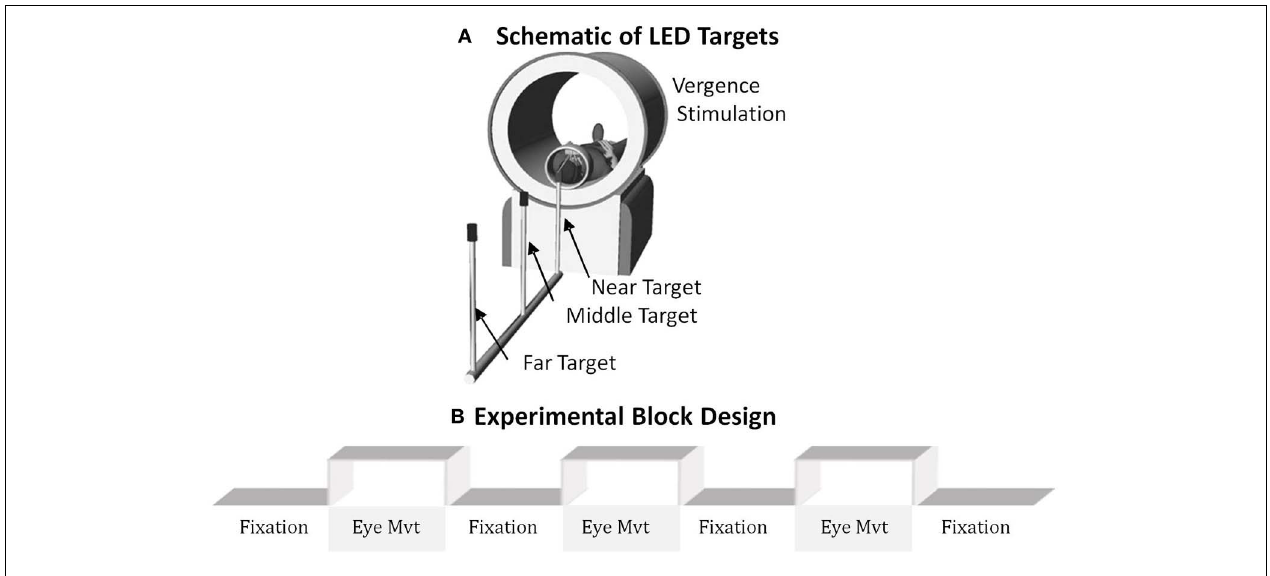
FIGURE 1 | (A) Schematic of the LED targets showing visual stimuli. (B) The experimental block design was composed of sustained fixation (denoted as Fixation) and vergence eye movements